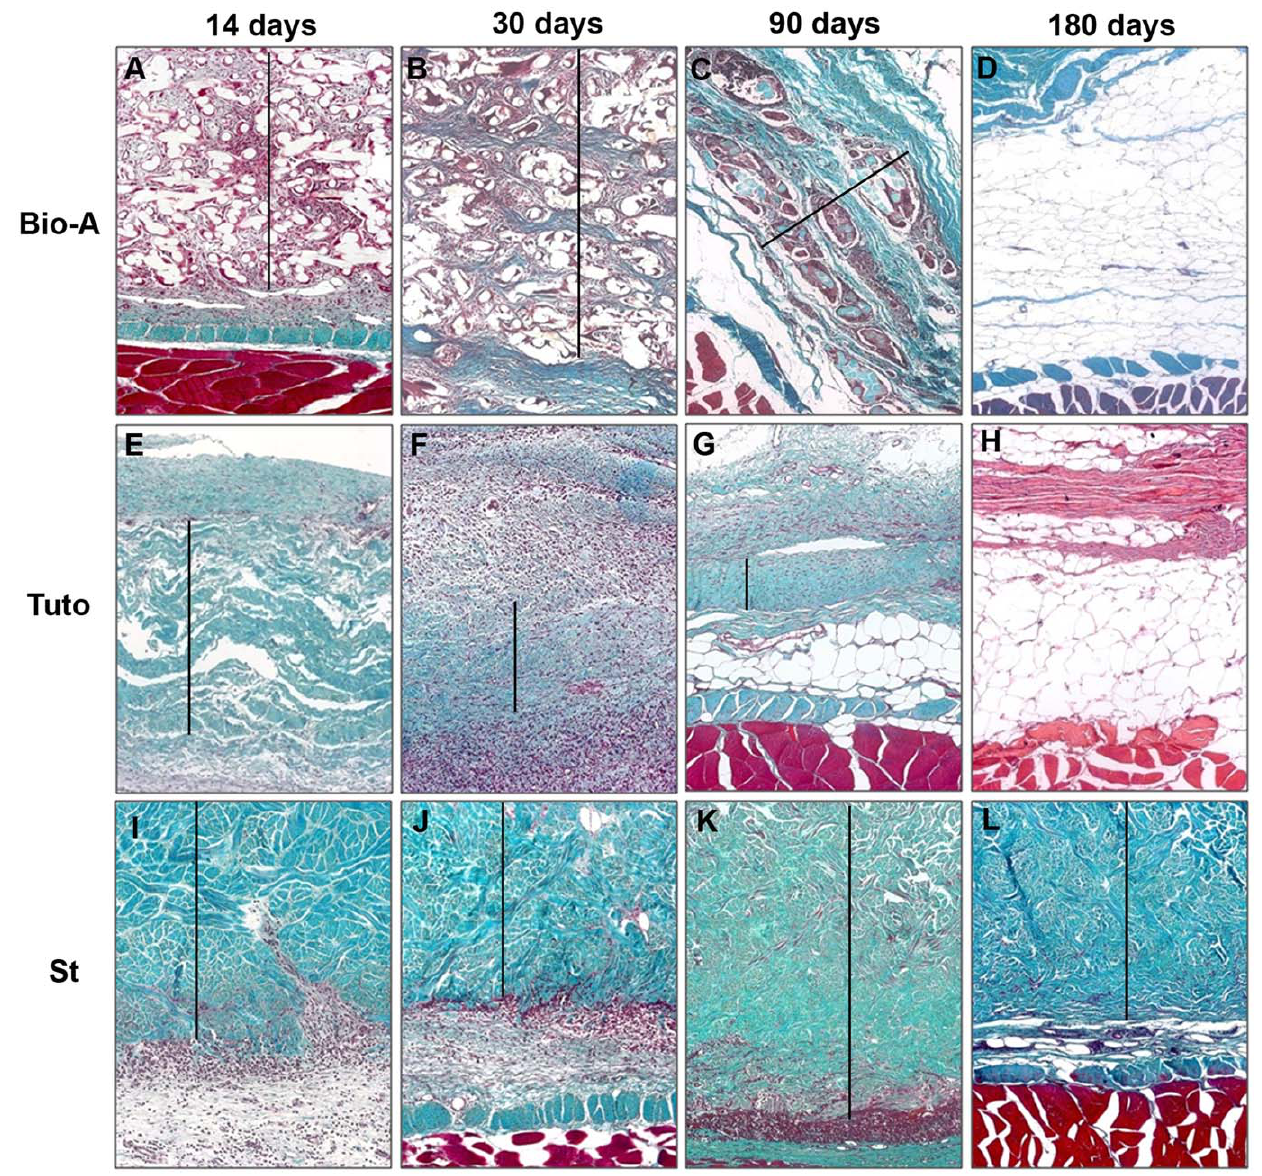
Figure 3. Light microscopy images. Tissue integration and prostheses degradation in the different timepoints (100 6 ). Bio-A (A–D) and Tuto (E–H) showed a gradual infiltration of host tissue and was completely degraded by 180 days post-implantation. St exhibited material encapsulation, without signs of degradation and low cell infiltration at 180 days (I–L). (– Prosthesis).